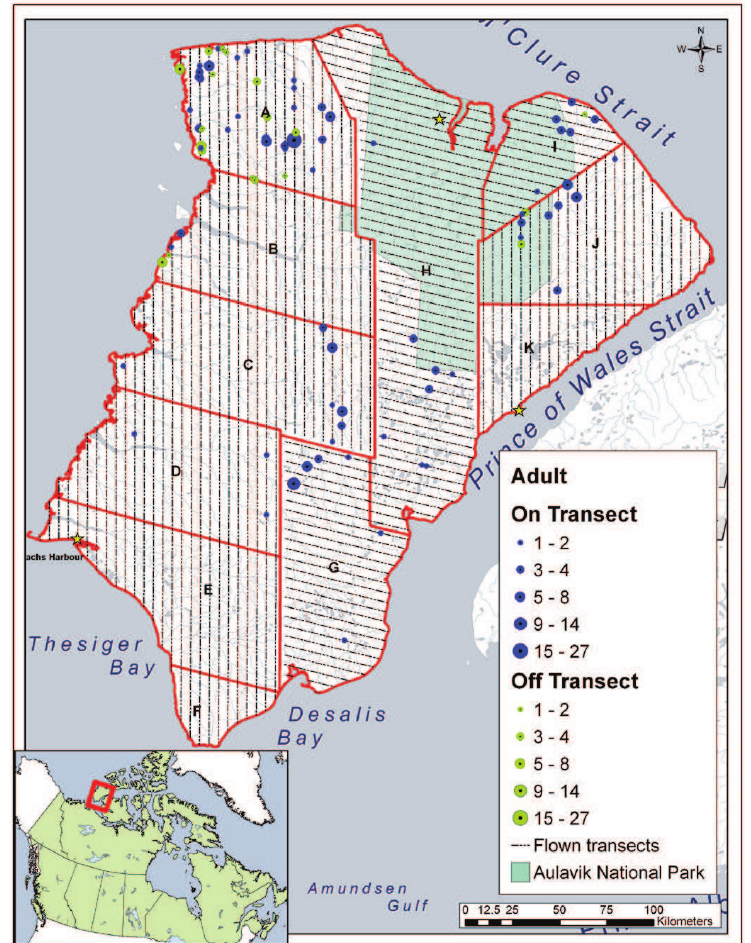
Fig. 1. Distribution of adult Peary caribou observed both on and of transect during an aerial servey flown from July 17 – 26, 2010, on Banks Island, NWT.